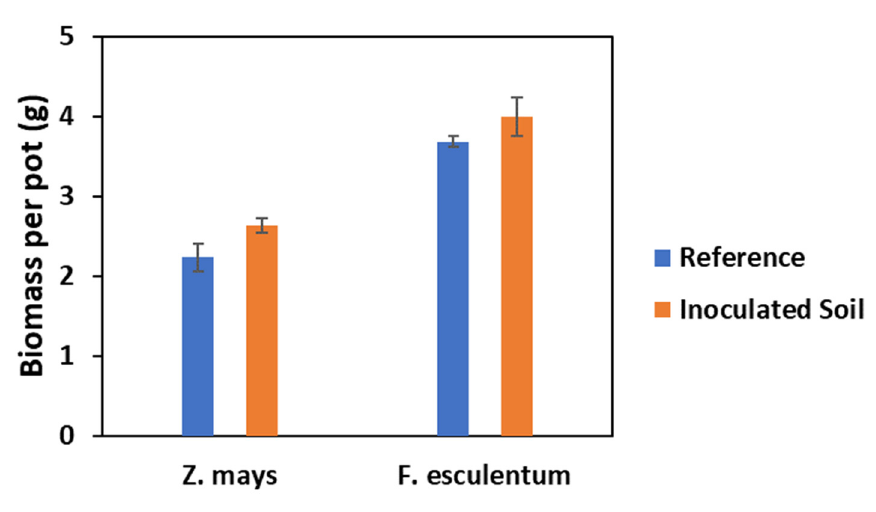
Figure 2. Effect of inoculation on shoot yield of Zea mays and Fagopyrum esculentum (mean ± SE, n = 3).